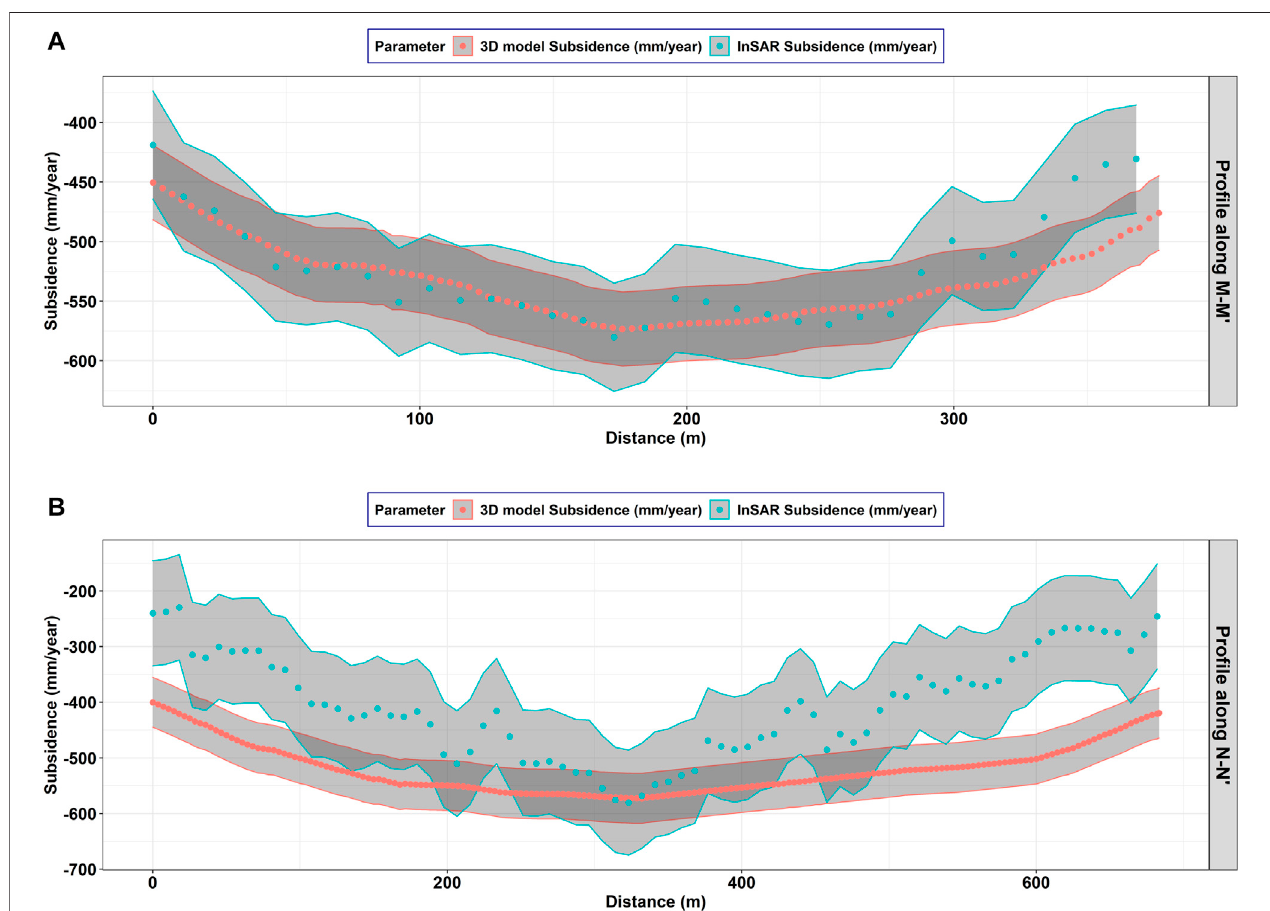
FIGURE 7 | Land subsidence pro fi les of FDM model and InSAR result along (A) M – M ′ and (B) N-N ′ .